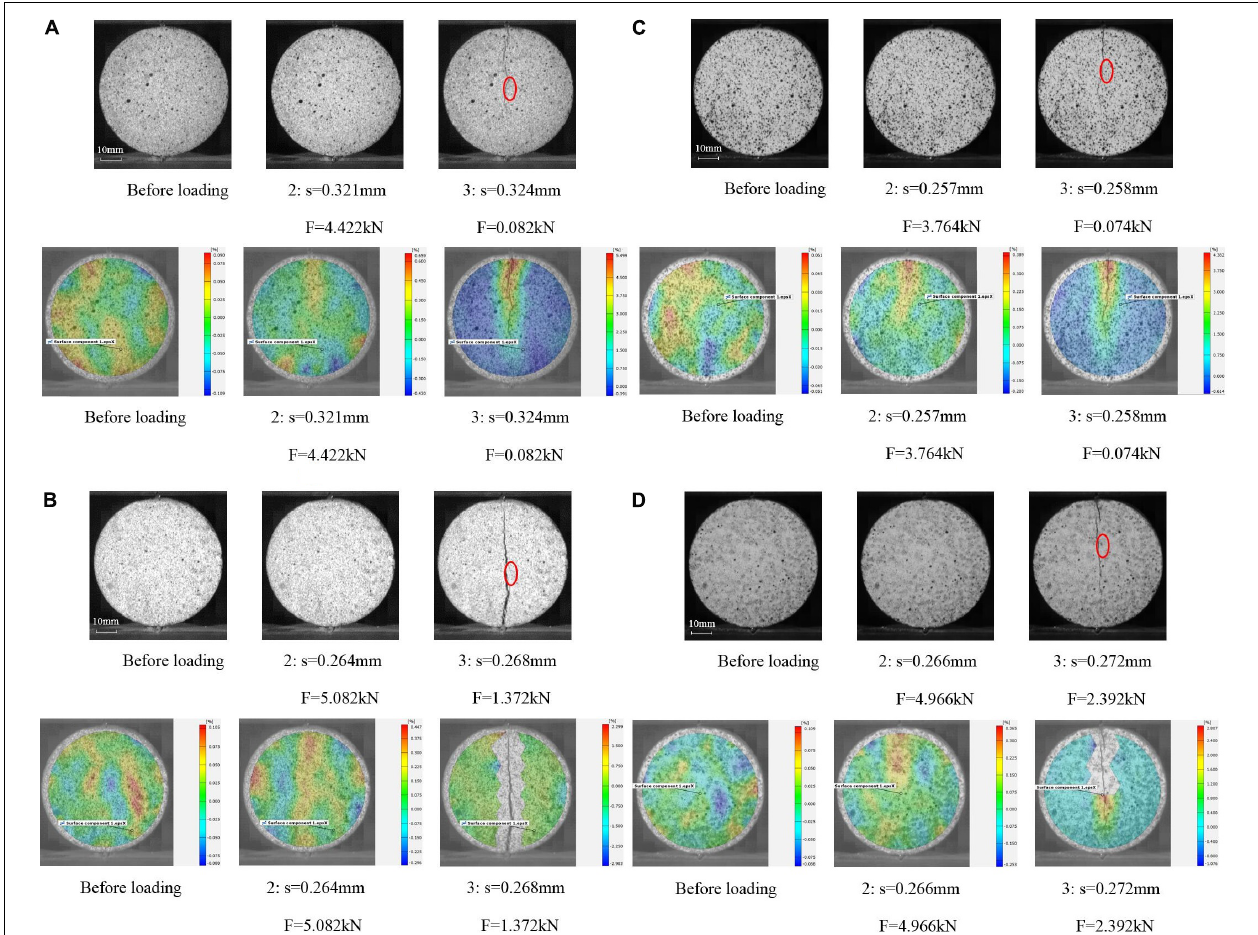
FIGURE 6 | Failure modes and evolution process of full strain field on the surface of BD gritstone specimens in Cd group under static splitting tension (The Arabic numbers correspond to those in Figure 4B ): (A) specimen A1; (B) specimen W1; (C) specimen Wp1; (D) original specimen. Red circle is the sampling position used in SEM.